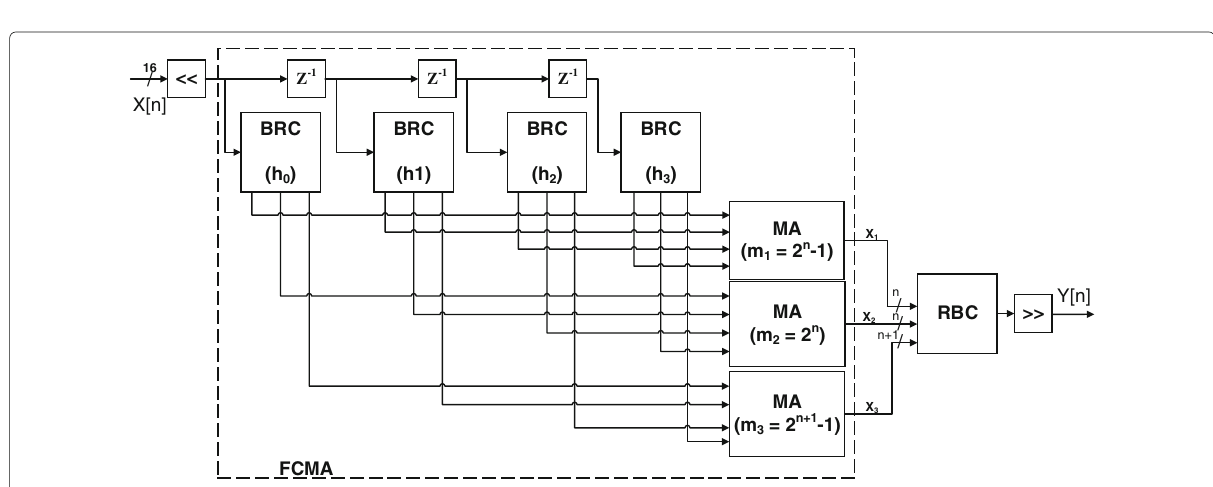
Fig. 4 The block diagram of DB2 RNS-based architecture. BRC stands for binary-to-residue converter, RBC stands for residue-to-binary converter and MA represents for modulo